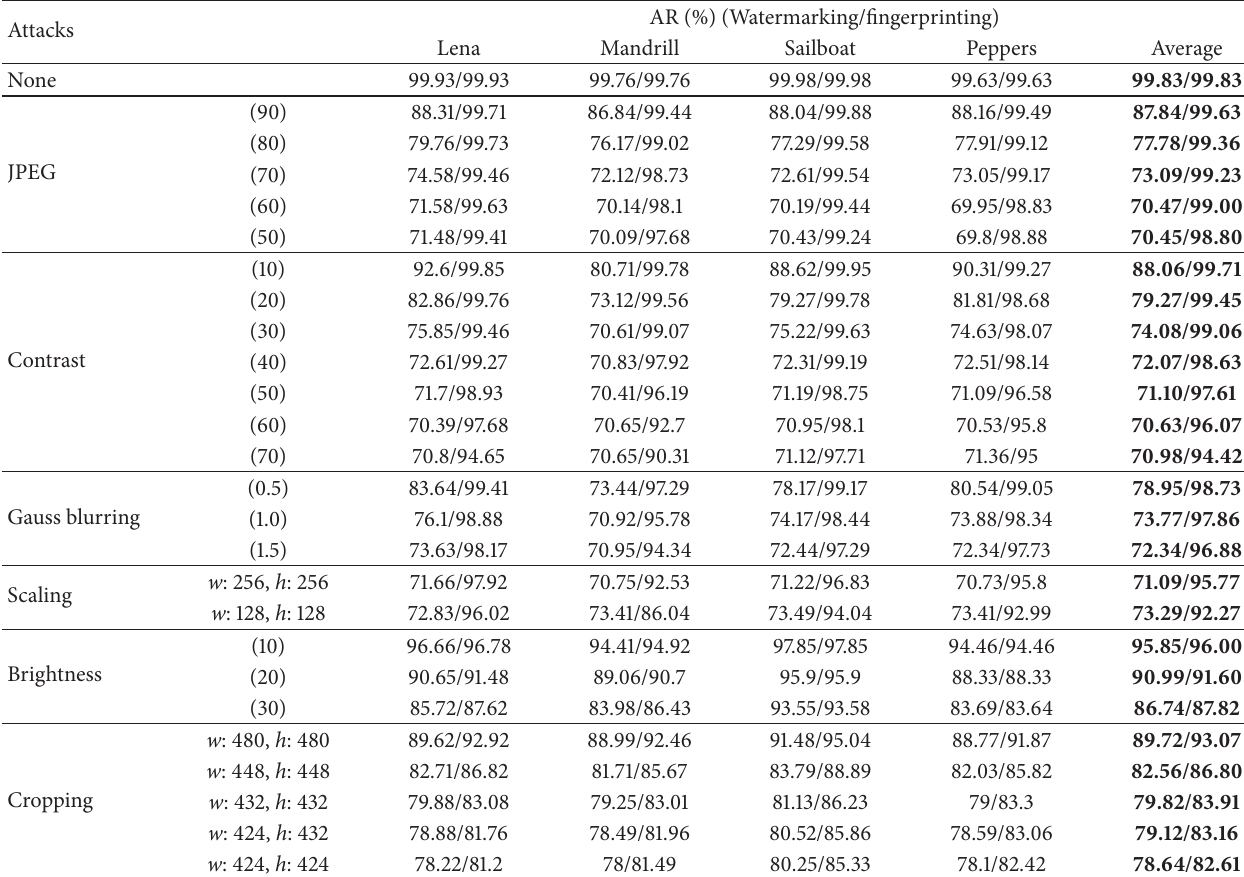
Table 3: The resulting AR values of the test